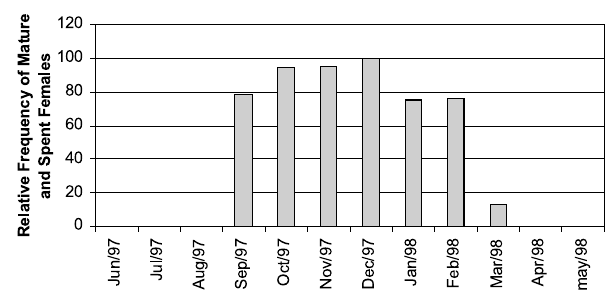
Fig. 5: Monthly average condition factor of males of Menticirrhus littoralis . Animals captured at Cidreira’s fishing pier, Rio Grande do Sul, Brazil, from June 1997 to May 1998.